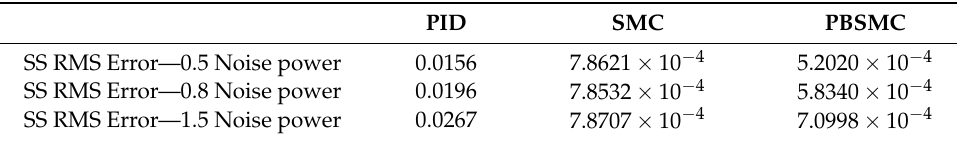
Table 6. Error Performance and Convergence Time for Controllers. Table 7. Error Performance Comparison for Different Noise